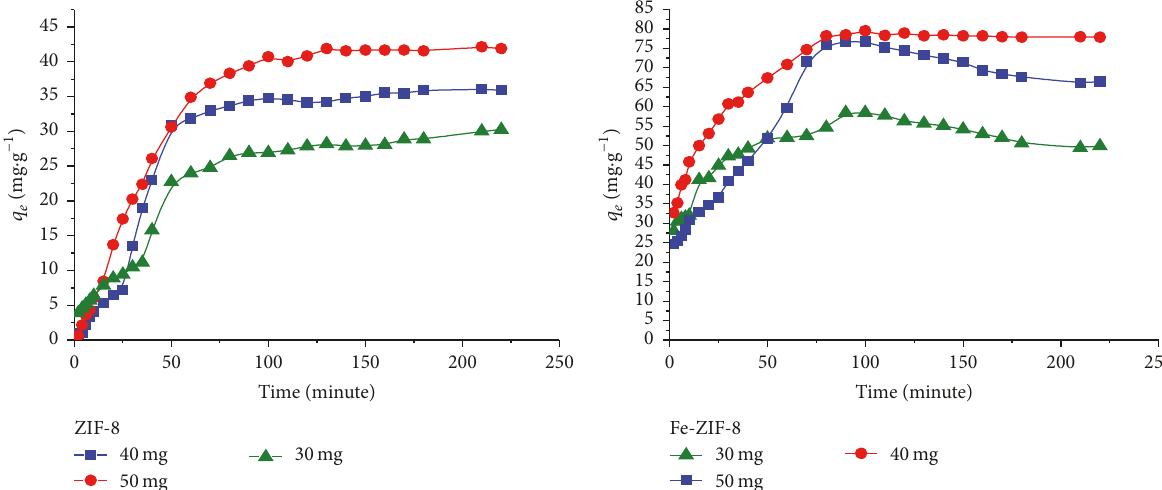
Figure 7: Effect of contact time on the adsorption of RDB by ZIF-8 and Fe-ZIF-8 ( 𝐶 8.2; 𝑉 = 500 ml, temperature = 30 ∘ C, and stirring rate = 500 rpm). RDB